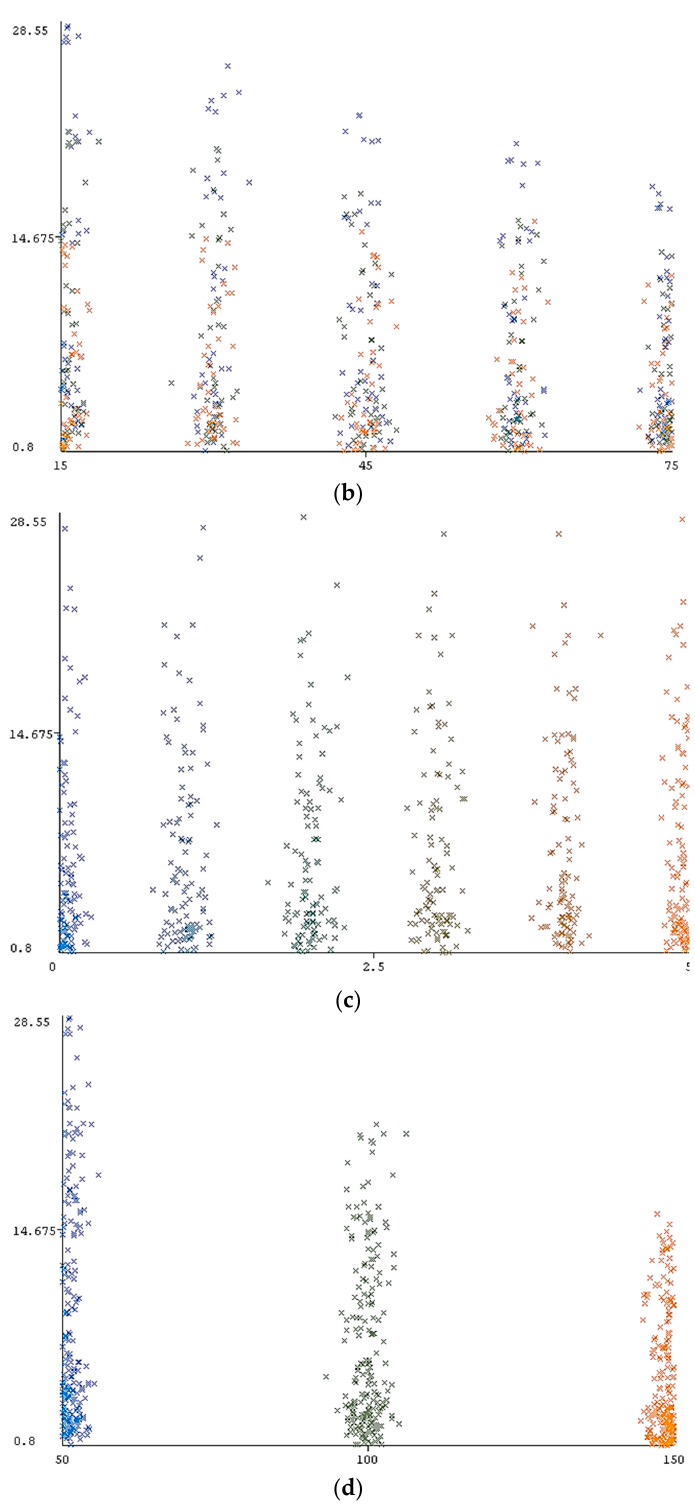
Figure 3. The relationship between the input parameters versus an obtained factor of safety (vertical axis). ( a ) Cu versus safety factor, ( b ) β versus safety factor, ( c ) b / B versus safety factor, ( d ) surcharge (w) versus safety